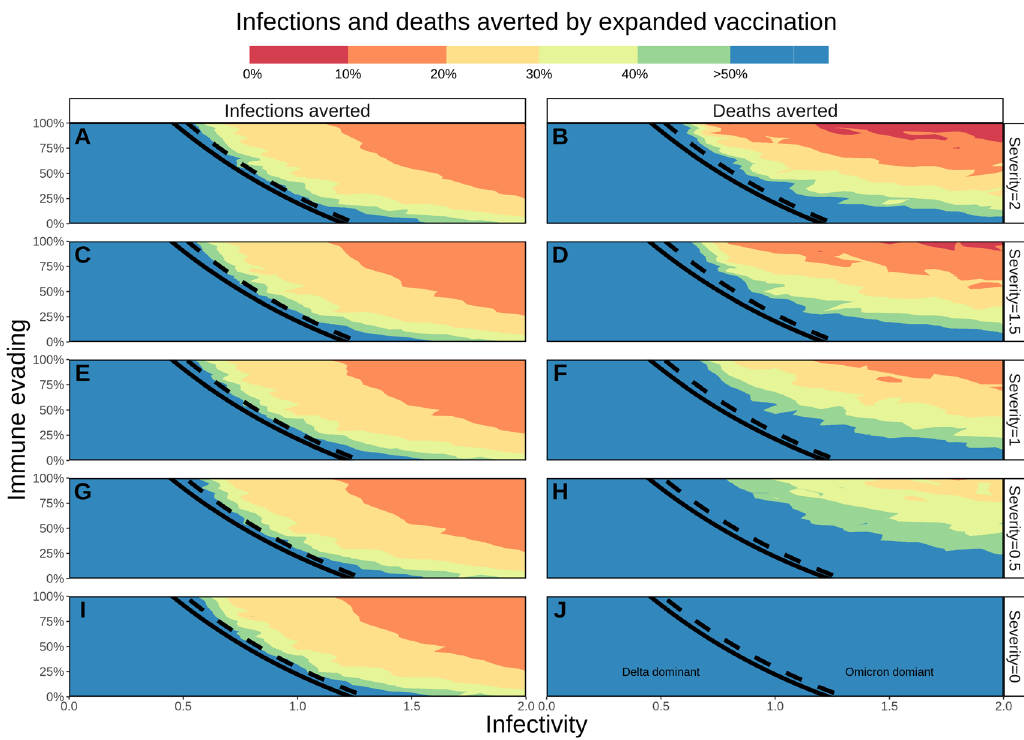
Fig. 2 Percentage of COVID-19 infections and deaths averted by third-dose vaccines for adults and vaccinating 5 – 11-year-olds with doses one and two. The threshold (50% prevalence) for Omicron ’ s future dominance within 6 months is presented by black lines (solid line for expanded vaccination, dashed for no future vaccination). A , C , E , G , and I represent the percentage of infections averted, B , D , F , H , and J the percentage of deaths averted due to expanded vaccination, with colour representing % averted. Rows represent Omicron ’ s potential severity (0 to 2) relative to Delta (1), horizontal axes represent Omicron ’ s potential infectivity (0 to 2) relative to Delta (1) and left vertical axes represent Omicron ’ s potential immune-evading capacity (0 to 100%). The maximum percentage of burden averted is capped at 50%, with the blue area extending to values >50%.